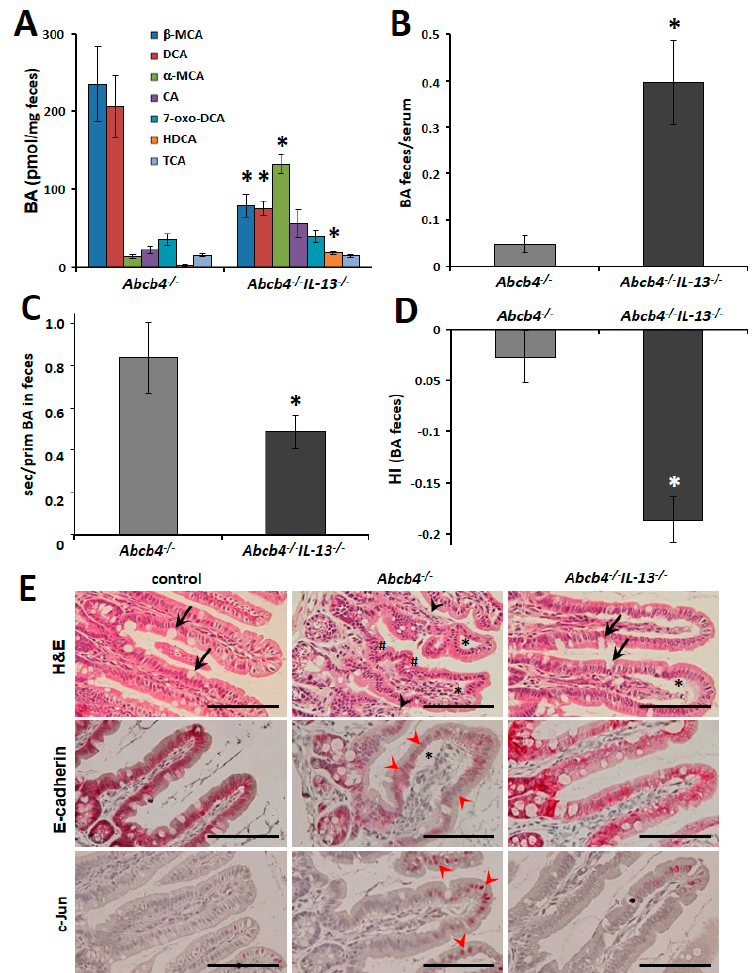
Figure 4. Restored bile acid excretion pattern improved ileal integrity. ( A ) Two of the seven most concentrated bile acids were significantly reduced in the feces of 8-week-old Abcb4 − / − /IL-13 − / − mice, while the concentration of three bile acids were increased. ( B ) The ratio of bile acid excretion (feces/serum) was increased 8-fold in 8-week-old Abcb4 − / − /IL-13 − / − mice. ( C,D ) The ratios of secondary to primary bile acids ( C ) and hydrophobicity index ( D ) of fecal bile acids were reduced in feces of 8-week-old Abcb4 − / − / IL-13 − / − mice. Values are means ± SEM for n = 5 ( Abcb4 − / − ) and n = 6 ( Abcb4 − / − / IL-13 − / − ) for fecal BA analysis. * p < 0.05 Abcb4 − / − vs. Abcb4 − / − / IL-13 − / − . BA bile acid, wt wild type. ( E ) H&E staining as well as immunostaining for E-cadherin and c-Jun demonstrate blunted and crippled villi (#), loss of goblet cells (arrows), and separation of villus epithelium (*) from underlying lamina propria in Abcb4 − / − mice and amelioration of these symptoms in Abcb4 − / − / IL-13 − / − mice . Note the tremendous loss of E-cadherin and the distinct nuclear c-Jun-staining in epithelia at the tips of villi in Abcb4 − / − mice (red arrowheads, middle and lower panels). Magnification 200 × , bars 100 µ m. Abbreviation: HI hydrophobicity